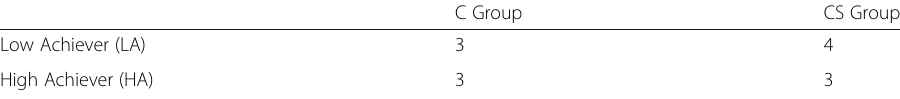
Table 3 Number of LA and HA Participants Involved in Interviews for Two